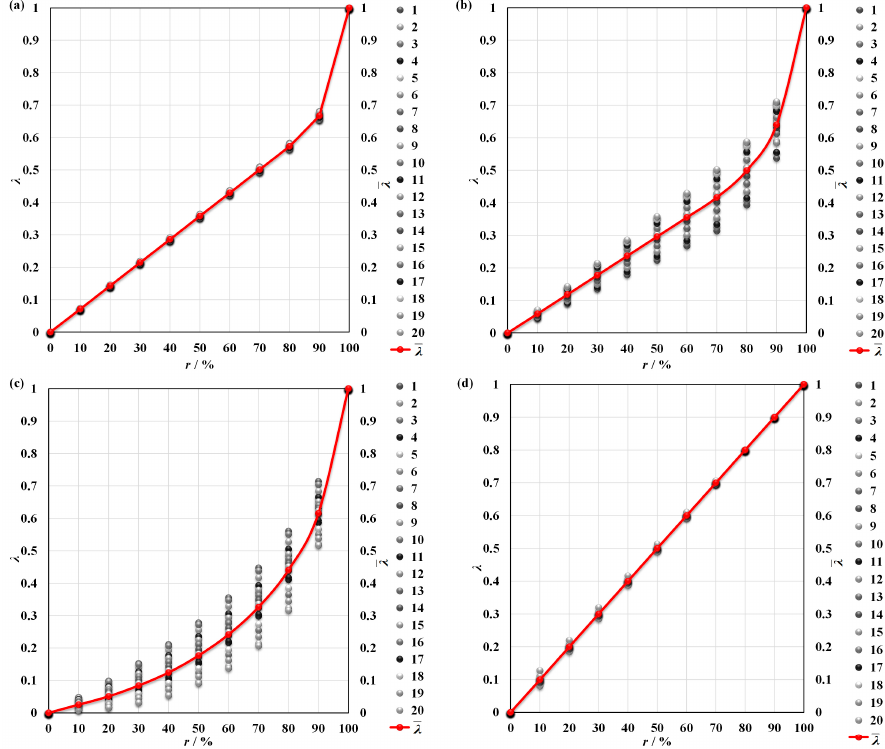
Figure 13. Evolution of dimensionless displacement: ( a ) case 1, ( b ) case 2, ( c ) case 3, ( d ) case 4.